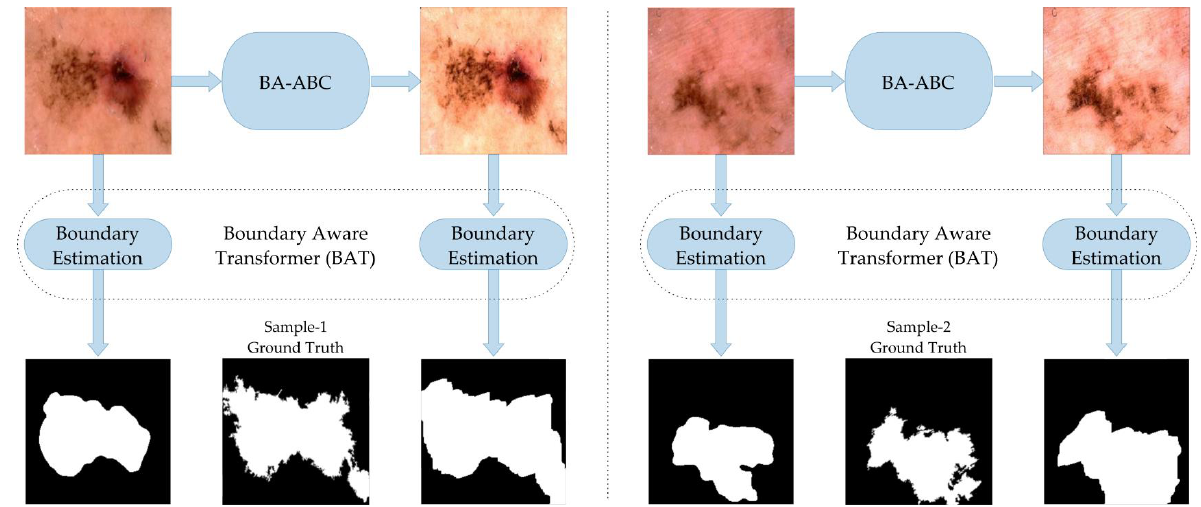
Figure 4. Results with BAT algorithm.